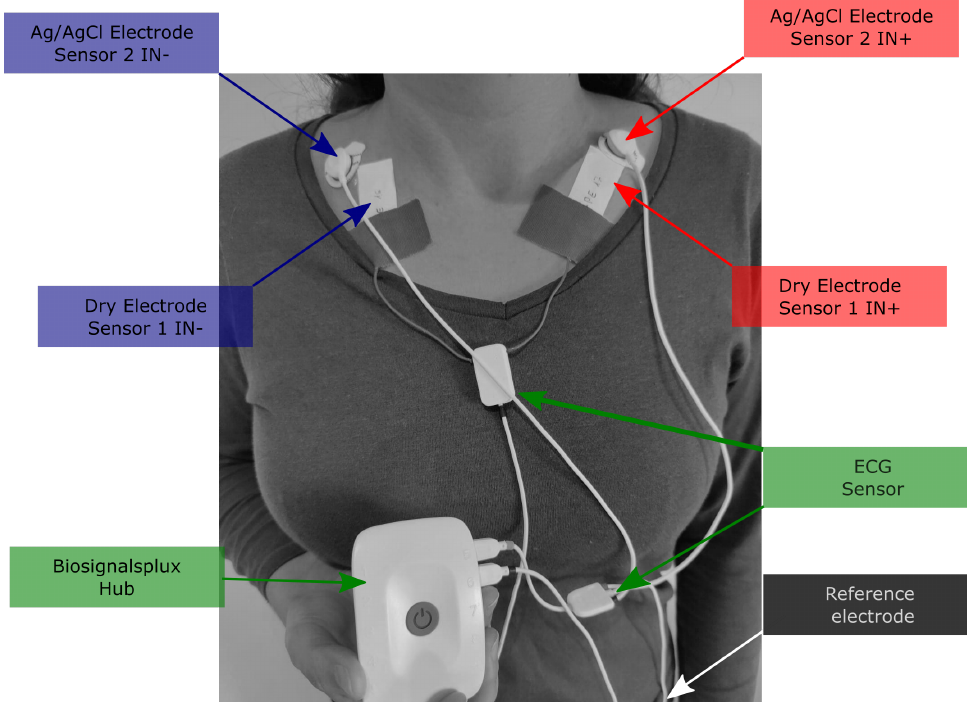
Figure 3. Electrodes’ placement.